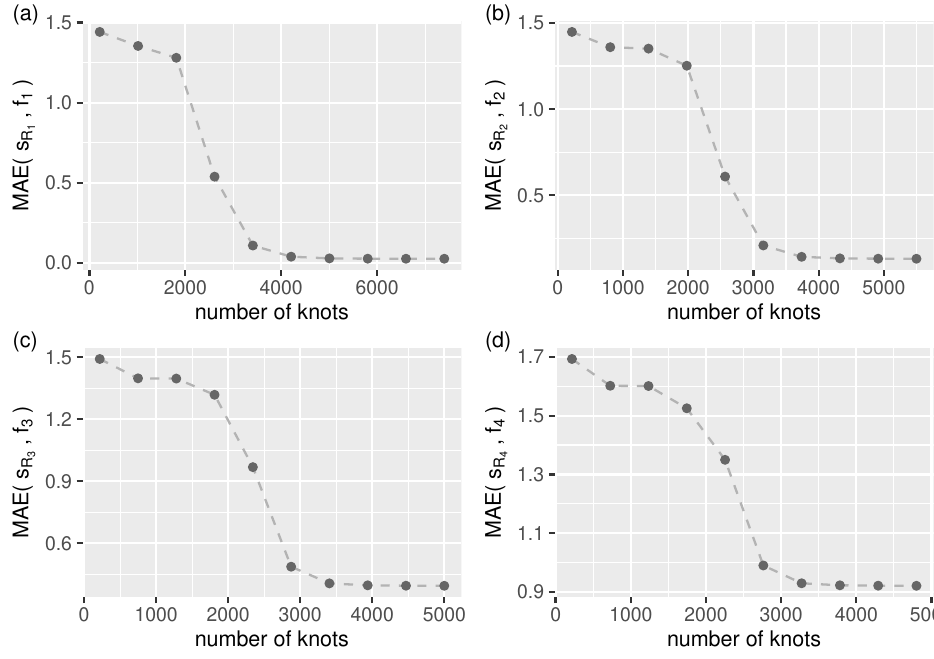
Figure 5. Approximation mean absolute error (Equation (28)) as a function of smooth.spline number of knots (segments) for all test streams, ( a – d ) f 1 – f 4 (in all cases: n = 10 6